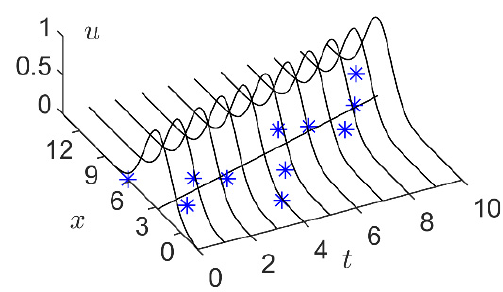
Figure 2. Different types of fuzzy information granules. ( a ) time series data; ( b ) interval fuzzy infor- mation granule; ( c ) triangular fuzzy information granule; ( d ) Gaussian fuzzy information granule.